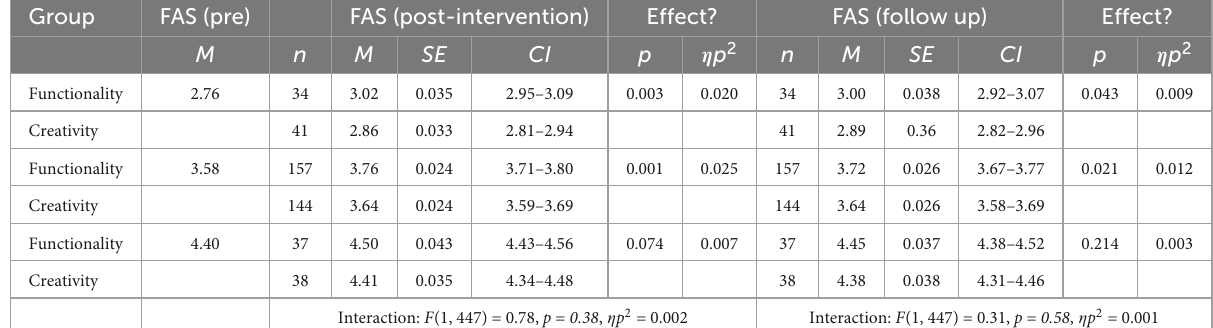
TABLE 6 Summary of intention-to-treat (ITT) analysis for functionality appreciation (FAS), including estimated marginal means and effects of the intervention at baseline values of FAS: one-standard deviation below the mean, the mean, and one-standard deviation above the mean, as well as the interaction effect (baseline FAS and study arm) on FAS at post-intervention and 1-month follow up ( N = 451). Group FAS